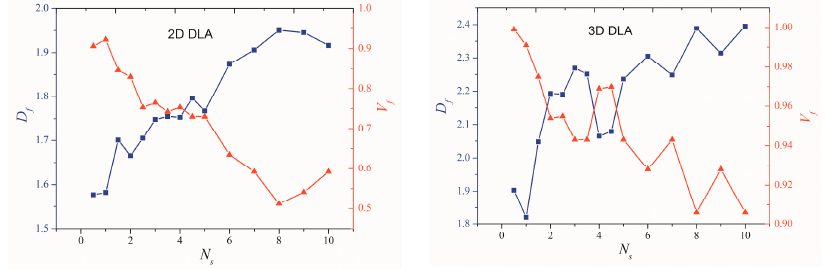
Figure 7. Effect of motion step length on the fractal dimension and porosity of 2D and 3D DLA aggregates.